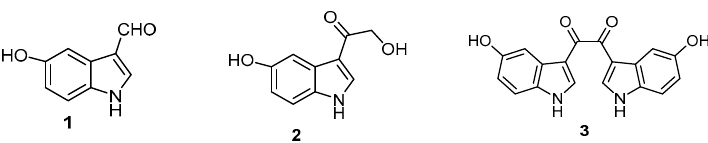
Figure 1. Chemical structures of 5-hydroxyindole-3-aldehyde ( 1 ), hyrtiosin A ( 2 ) and hyrtiosin B ( 3 ).